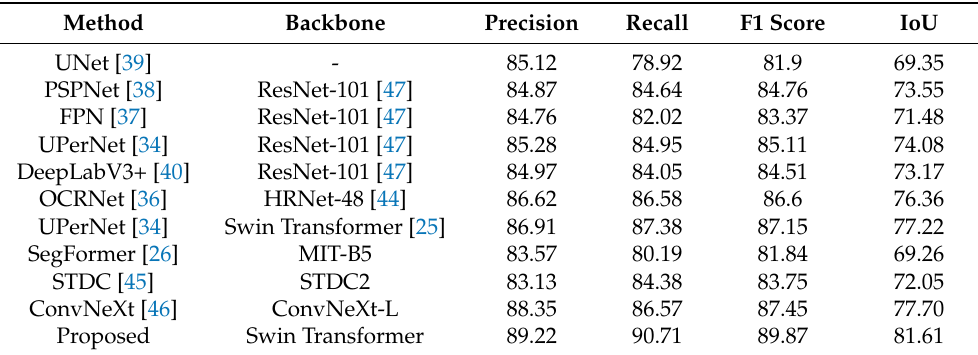
Table 1. Comparison of experimental results for the proposed method with semantic segmenta- tion